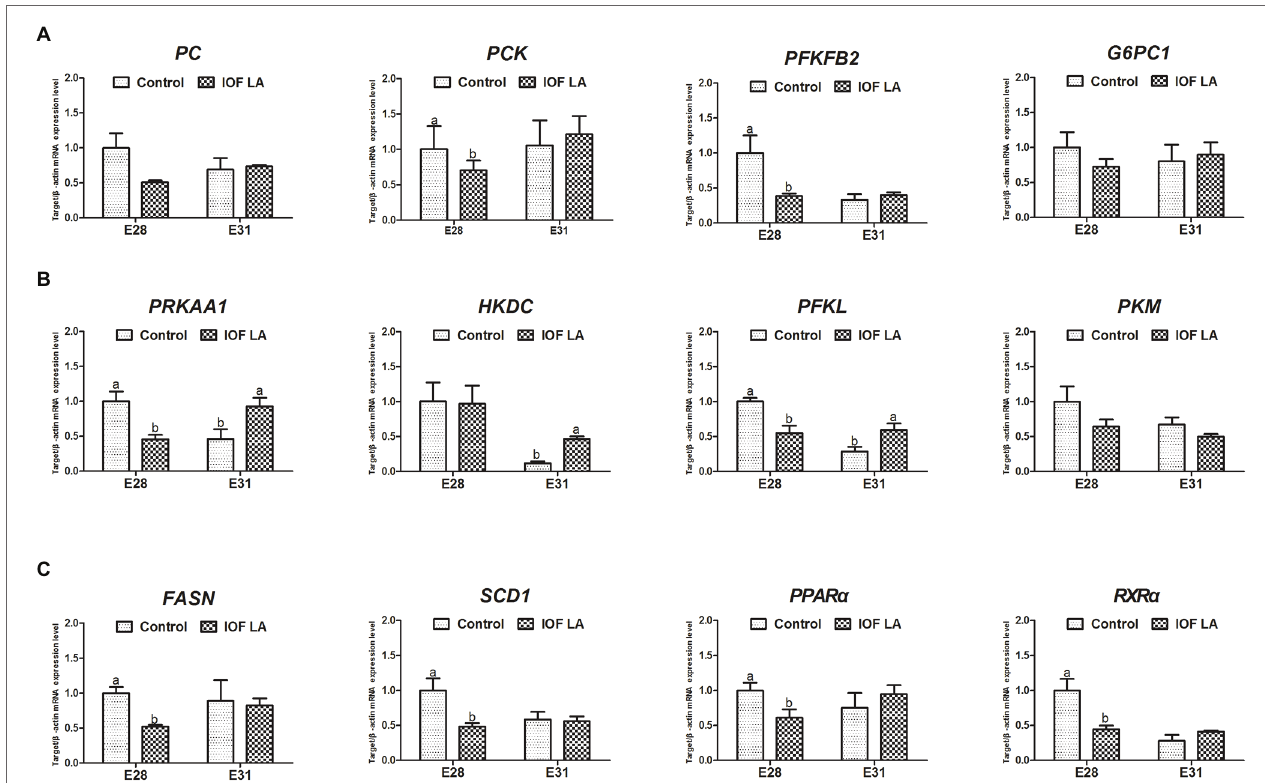
FIGURE 4 | Effect of in ovo feeding linoleic acid on the gene relative expression in the avian model. Control group was in ovo injected with PBS, and IOF LA was the treatment group in ovo feeding linoleic acid on E25. (A) gene expression related to gluconeogenesis: PC , pyruvate carboxylase; PCK , phosphoenolpyruvate carboxykinase; PFKFB2 , 6-phosphofructo-2-kinase; G6PC1 , glucose-6-phosphatase; (B) gene expression related to energy homeostasis and glycolysis: PRKAA1 , protein kinase AMP-activated catalytic subunit alpha 1; HKDC , hexokinase; PFKL , phosphofructokinase; PKM , pyruvate kinase M1/2; (C) gene expression related to fatty acid synthesis and oxidation: FASN , fatty acid synthase; SCD1 , stearoyl-CoA desaturase; PPAR α , peroxisome proliferator-activated receptor alpha; RXR α , retinoid X receptor alpha. Data are expressed as mean ± SEM ( n = 6), and bars on the same sampled day with different lowercase letters indicated statistically significant differences ( t -test, p <